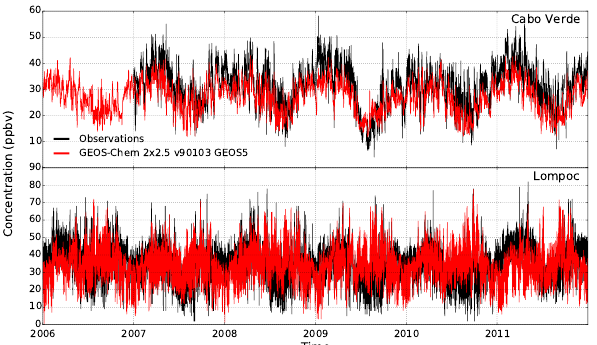
Figure 1. Time series of surface O 3 at Cabo Verde (16.51 ◦ N, 24.52 ◦ W) and Lompoc (34.73 ◦ N, 120.43 ◦ W) for the observations (black) and the GEOS-Chem model (red), between 2006 and